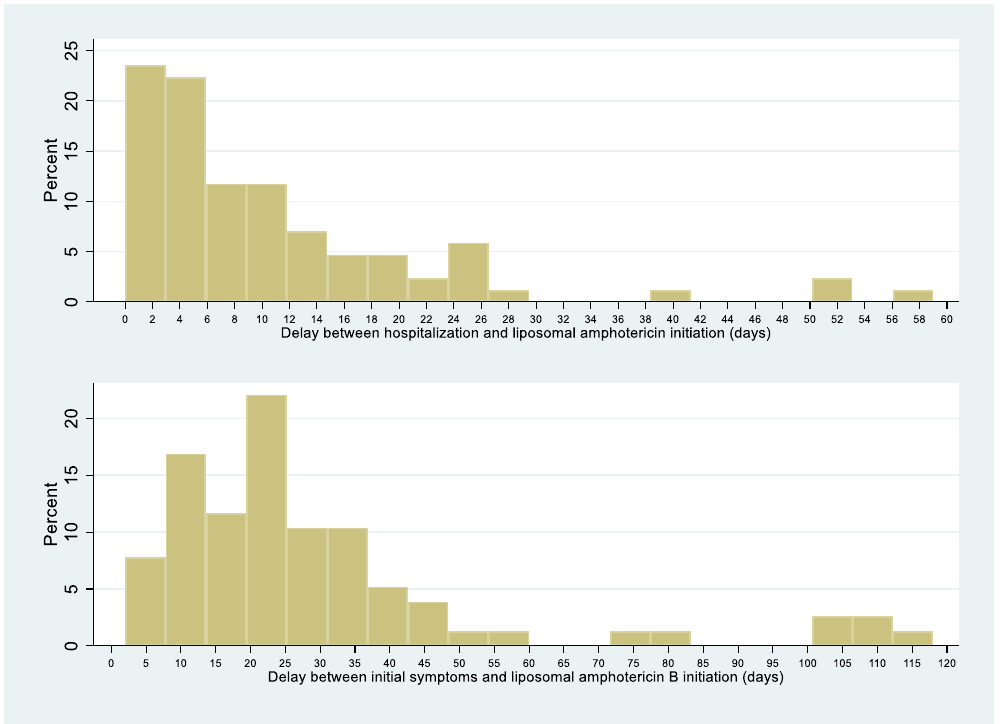
Figure 4. HIV-associated disseminated histoplasmosis: delay between initial symptoms, hospitalization, and liposomal amphotericin B initiation.